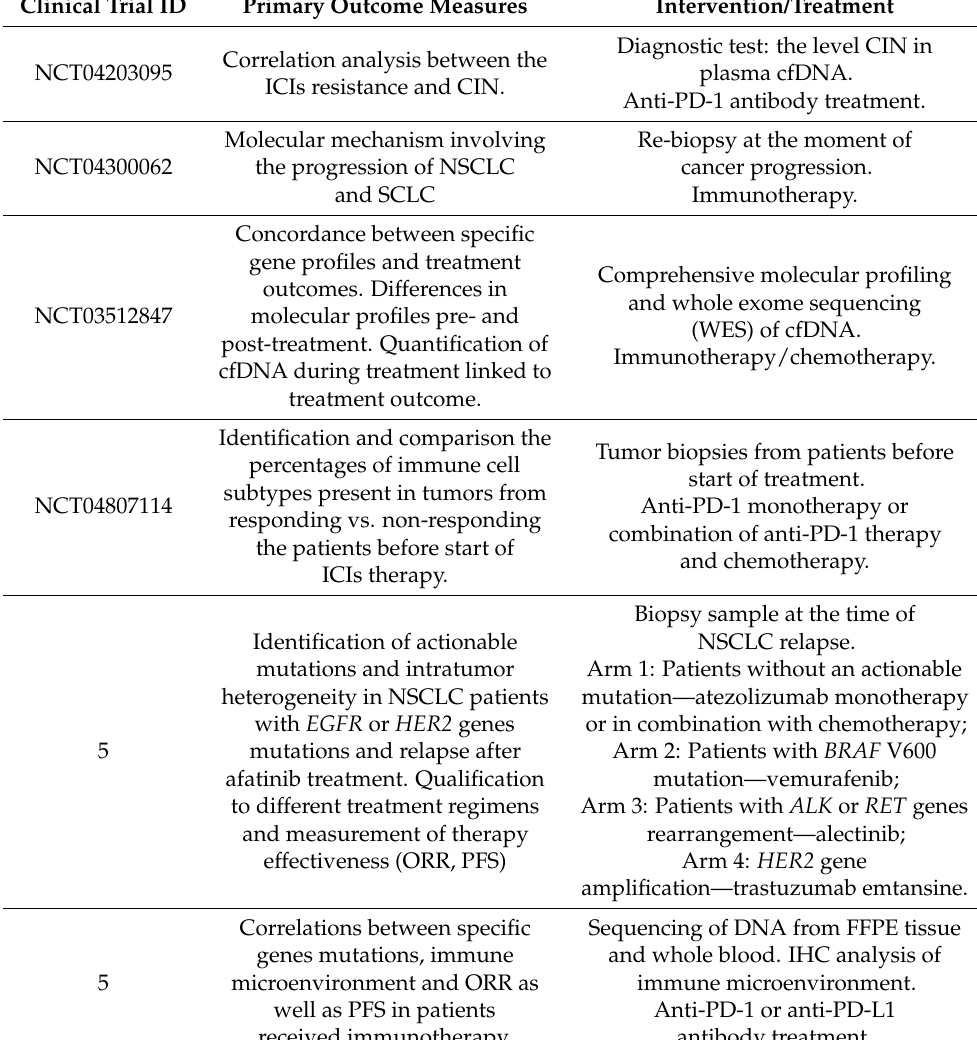
Table 1. Ongoing clinical trials investigating the genetic background of resistance to immunotherapy in lung cancer